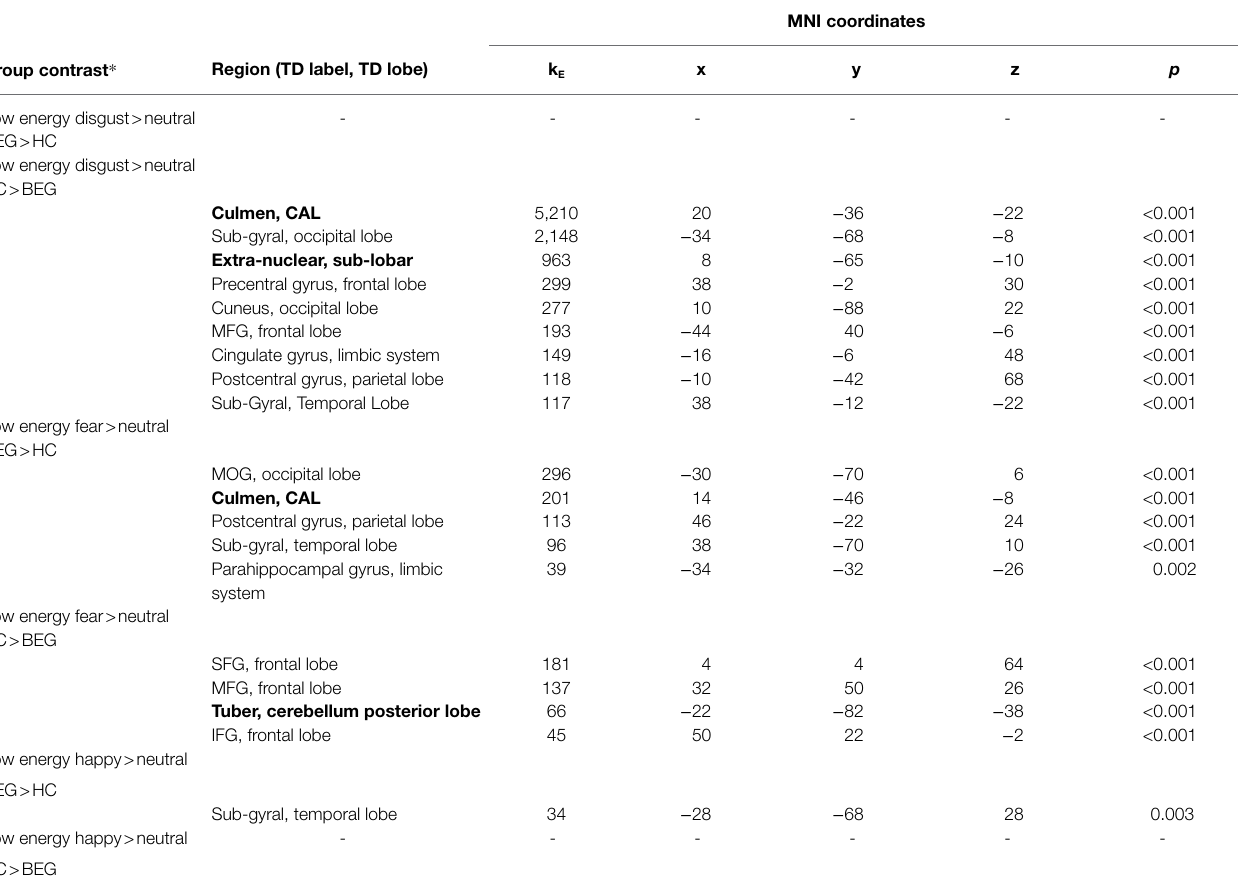
TABLE 2 | Neural activation while viewing low energy disgust, fear, and happy food images compared to neutral images, across groups.